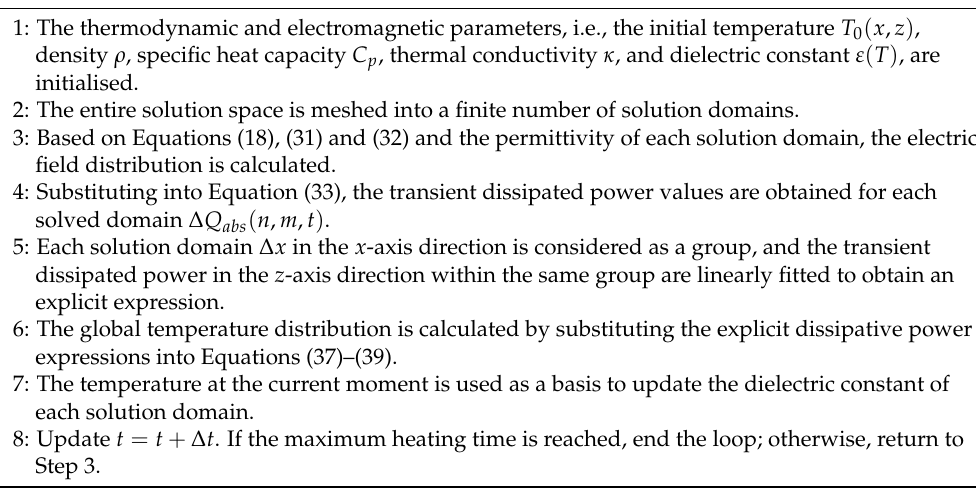
Algorithm 1: Algorithm for solving the microwave heating temperature distribution of the TE 10